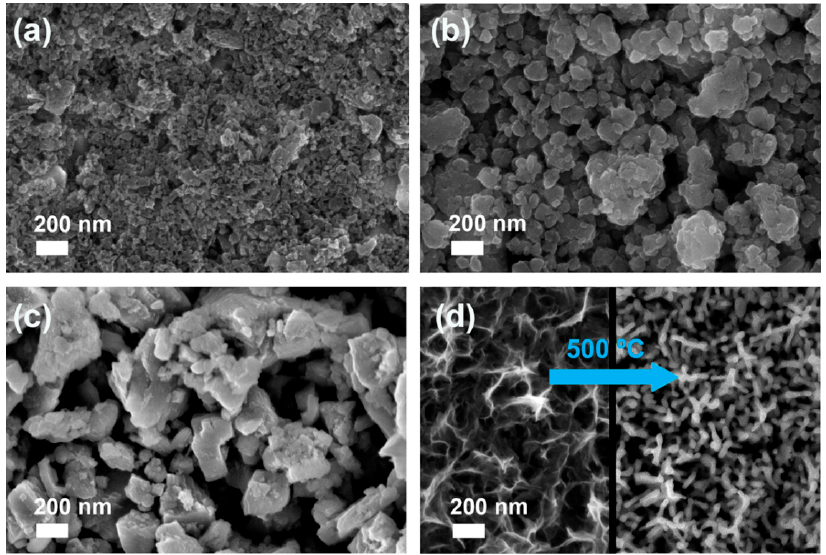
Figure 1. FE-SEM images of a top view of MnO 2 ( a ); Mn 2 O 3 ( b ) and Mn 3 O 4 ( c ) SC films after annealing at either 500 °C or 400 °C; ( d ) FE-SEM images of a top view of the ED film: as-prepared sample